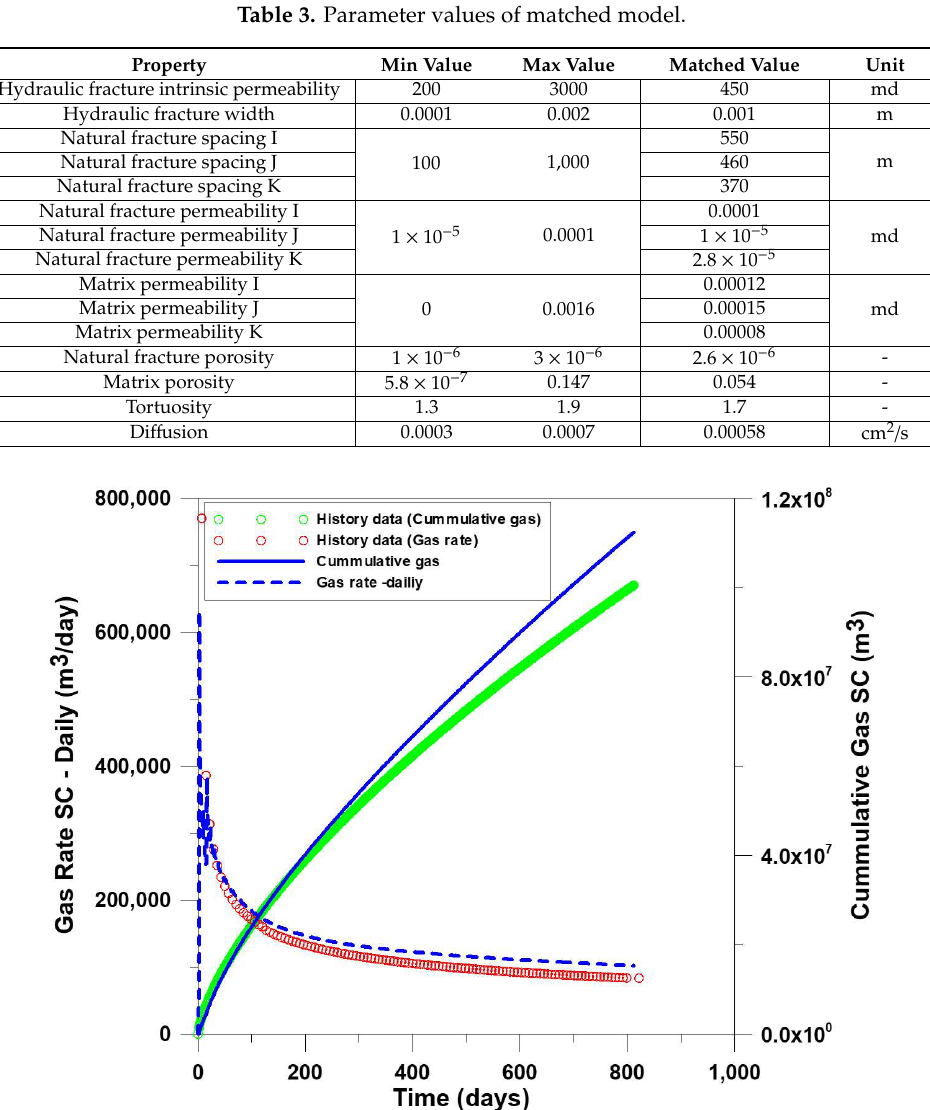
Figure 12. Production history matching result. Table 3. Parameter values of matched model.